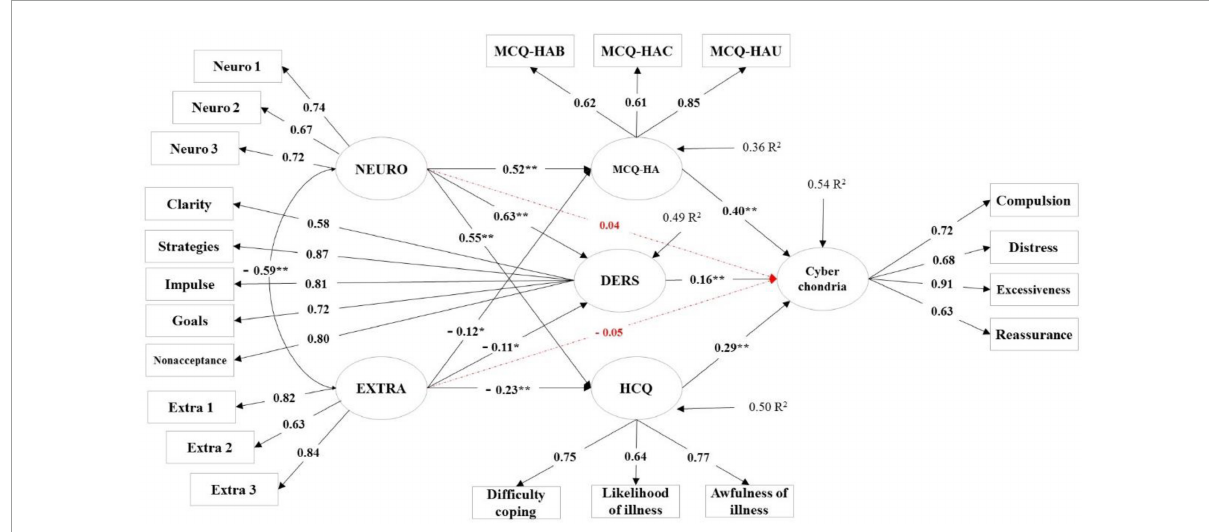
FIGURE2 Structural equation modeling of cyberchondria with standard coefficients. NEURO, neuroticism; EXTRA, extraversion; MCQ-HA, The Meta-Cognitions about Health Questionnaire; DERS, Difficulties in Emotion Regulation Scale; HCQ, The Health Cognitions Questionnaire; Clarity, lack of emotional clarity; Strategies, limited access to emotion regulation strategies perceived as effective; Impulse, difficulties in controlling impulsive behaviors over the distressed periods; Goals, inability to engage in goal-directed behaviors over the distressed periods; Non-acceptance, non-acceptance of negative emotions; Neuro 1, Neuro 2, Neuro 3, Parcels of NEURO; Extra 1, Extra 2, Extra 3, Parcels of EXTRA. * p < 0.05; ** p < 0.01.